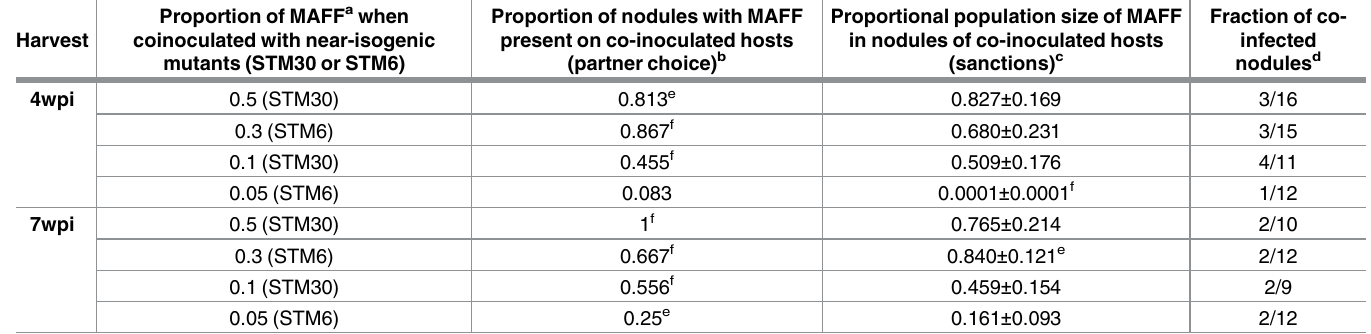
Table 1. Host control phenotypes when inoculated with two symbionts. Proportion of MAFF a when Harvest coinoculated with near-isogenic mutants (STM30 or